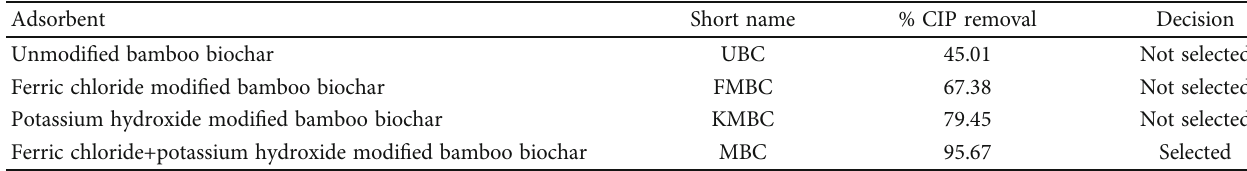
Table 2: Adsorbent screening test for CIP removal.